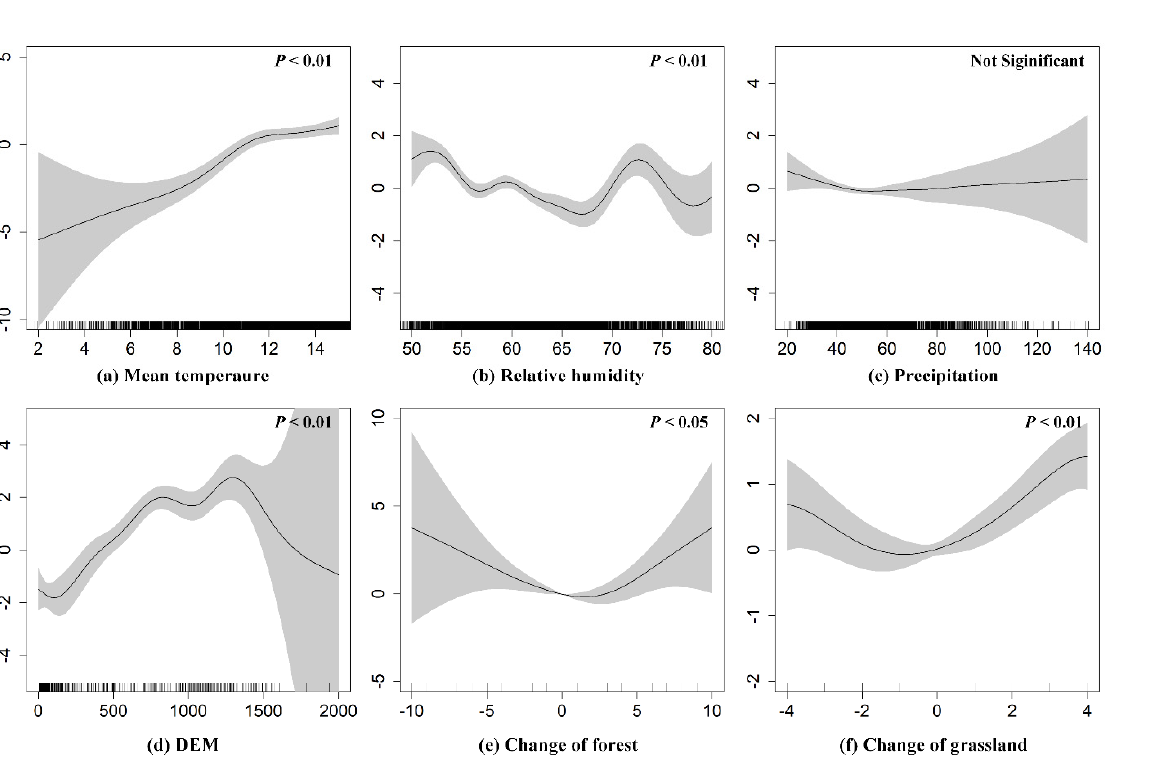
Table 4. Statistical results of spatial predictors based on the GAM model.